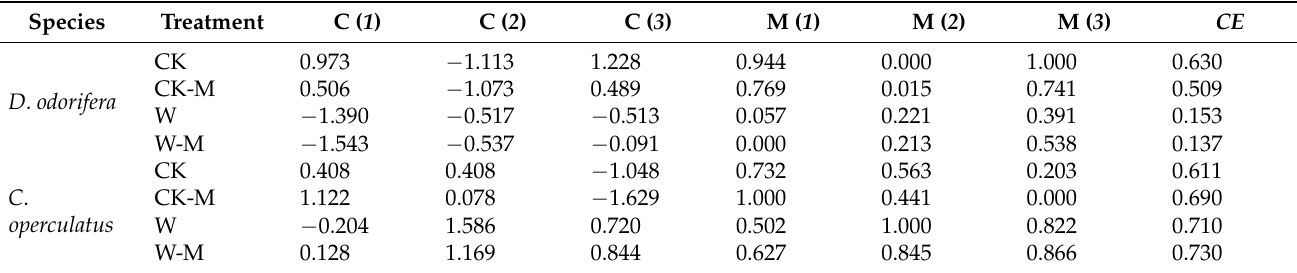
Table 4. Comparative analyses of the value of the principal component [C( µ )], membership function value [M( µ )], and comprehensive evaluation value (C E ) of C . operculatus and D . odorifera under all